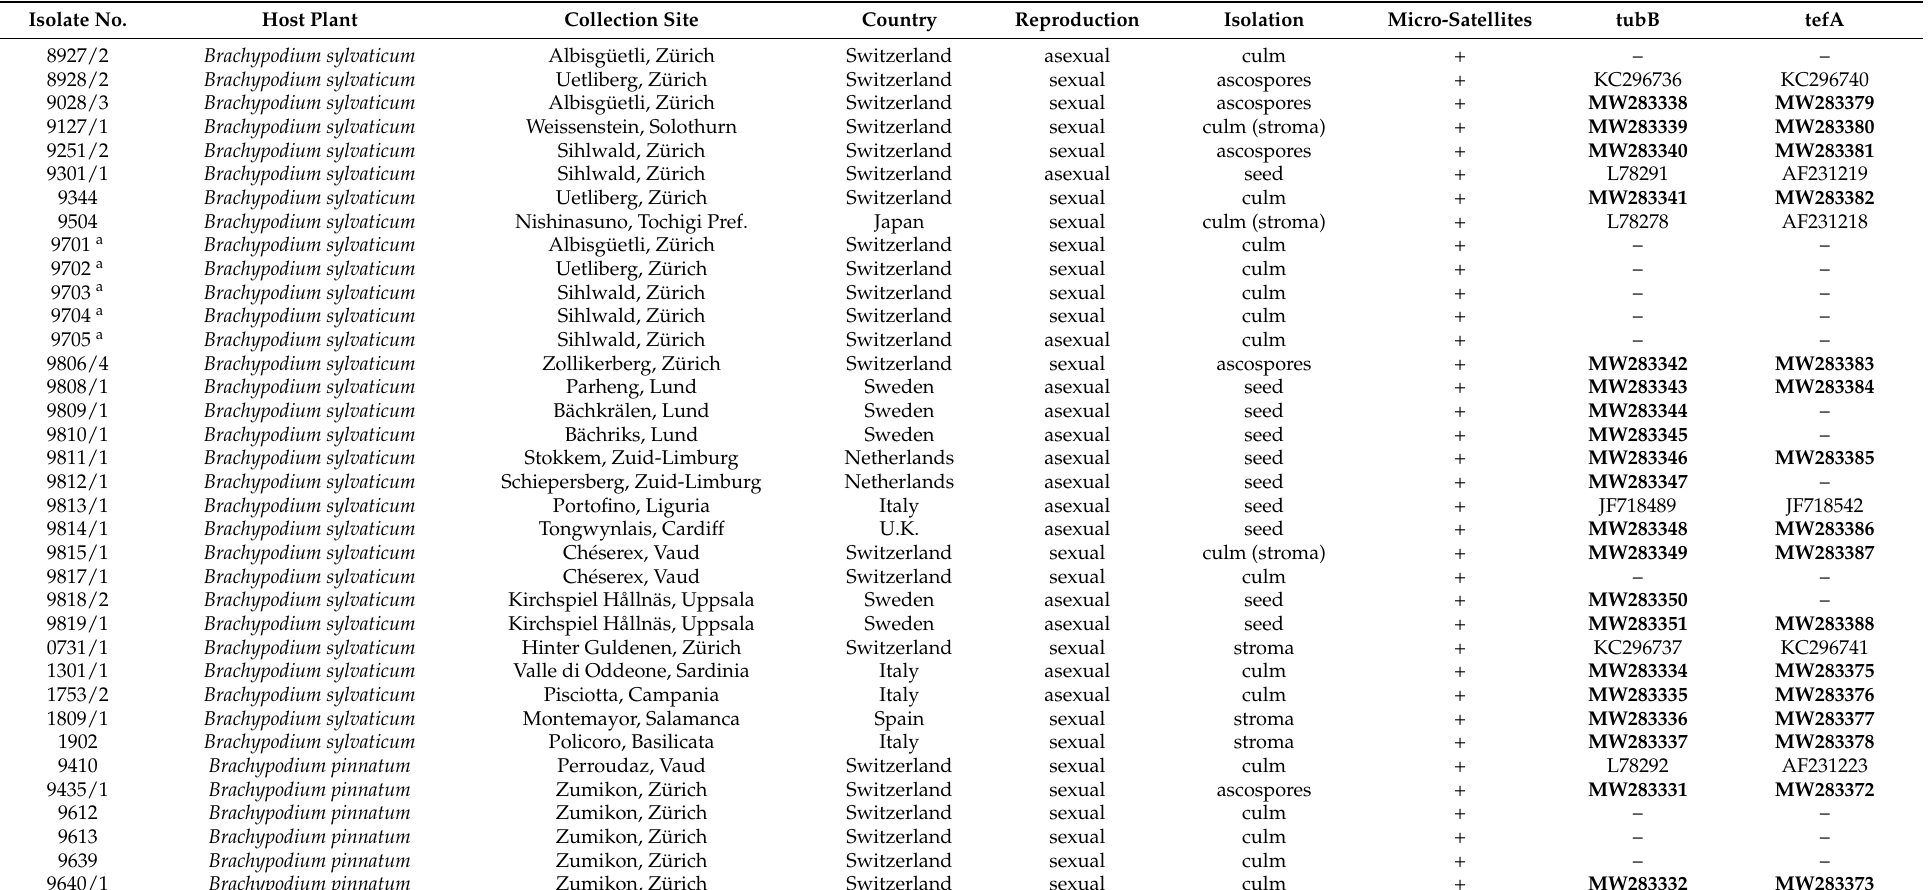
Table 1. Epichloë isolates from Brachypodium and Calamagrostis hosts used in this study with mode of reproduction (sexual or asexual) and source of isolation (culm, culm with stroma, seed, stroma tissue or ascopores). In addition, use for microsatellite analysis (+) and GenBank accession numbers are indicated (new sequences of this study are in